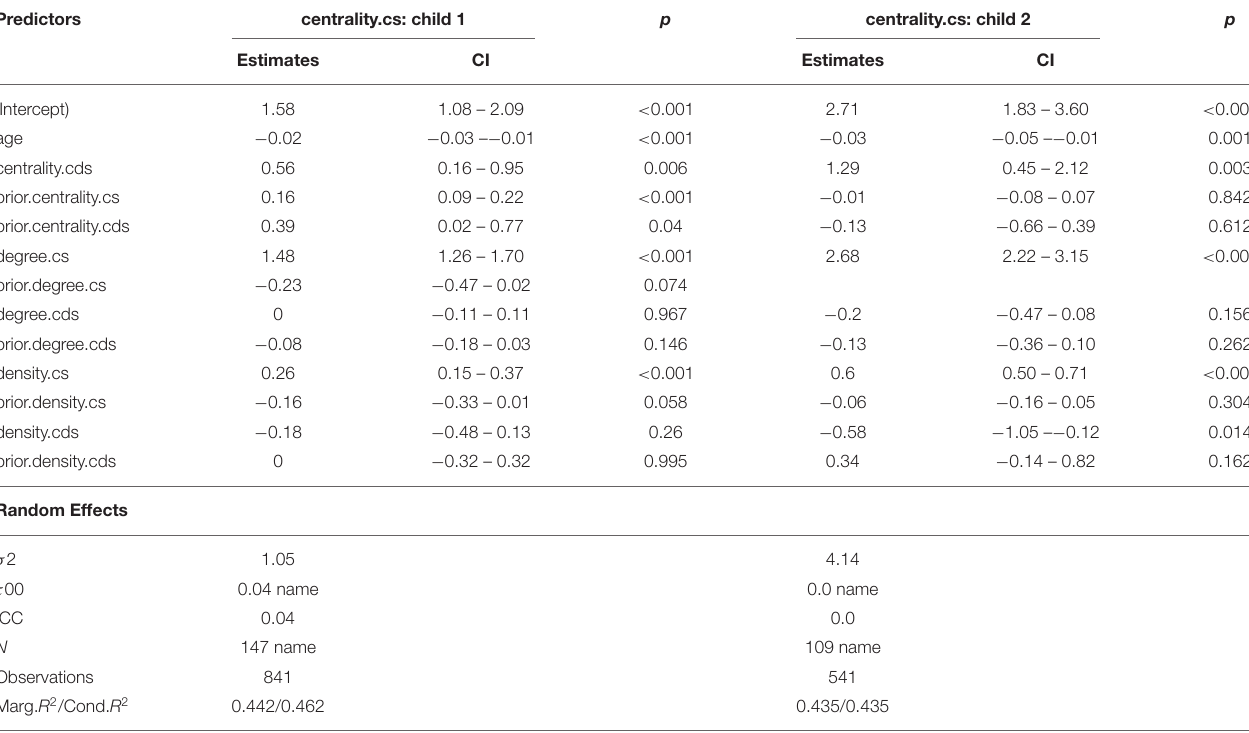
TABLE 8 | Linear mixed model: CS node centrality.